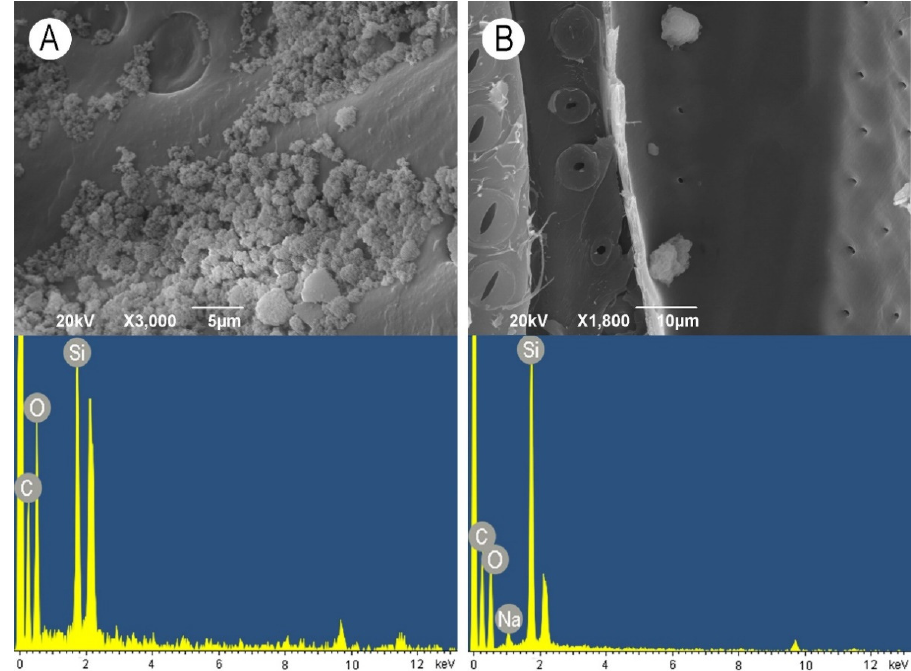
Figure 8. Scanning electron microscopy images of earlywood vessel wall surfaces (upper images) accompanied with the representative EDX spectra showing the elemental composition (bottom images). ( A ) SiO 2 nanoparticles, radial section, scale bar = 5 µ m. ( B ) Aqueous solution of water glass in combination with SiO 2 nanoparticles, radial section, scale bar = 10 µ m.